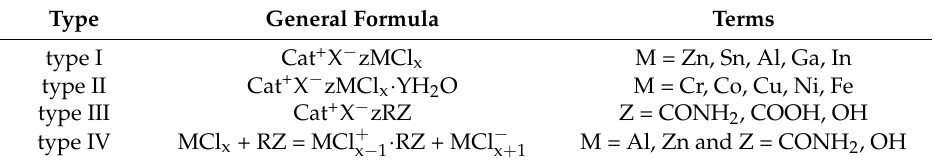
Table 1. General Formula for deep eutectic solvents (DES) classification. Adapted from [12].